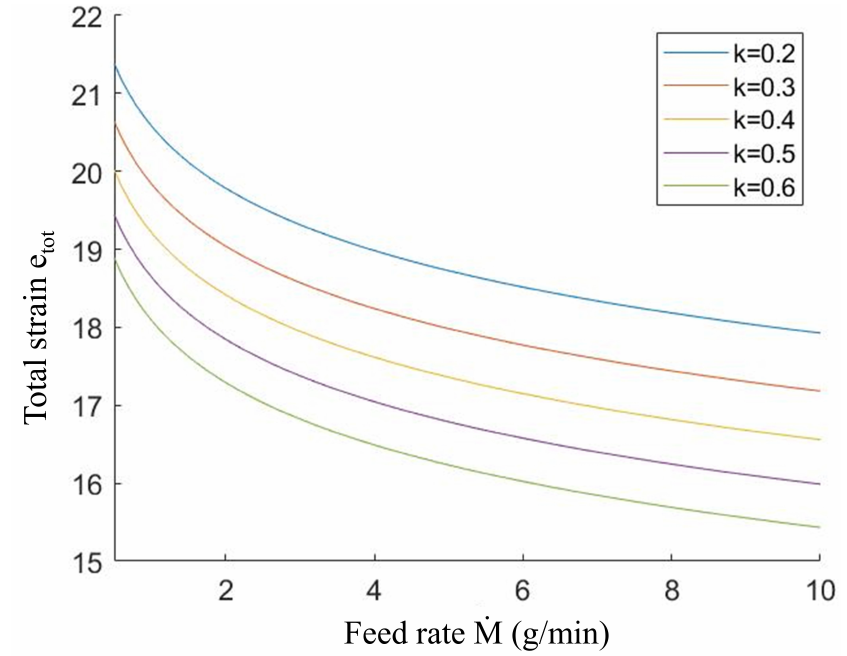
Figure 4. Estimation of total material strain e tot in the metal screw extrusion process as function of feed rate ˙ M and screw efficiency factor k for the manufacturing of Ø1.2 mm AA4043-TiC wires at ω = 3 rpm (0.314 rad/s). The calculations were based on the strain model developed by Skorpen et al.